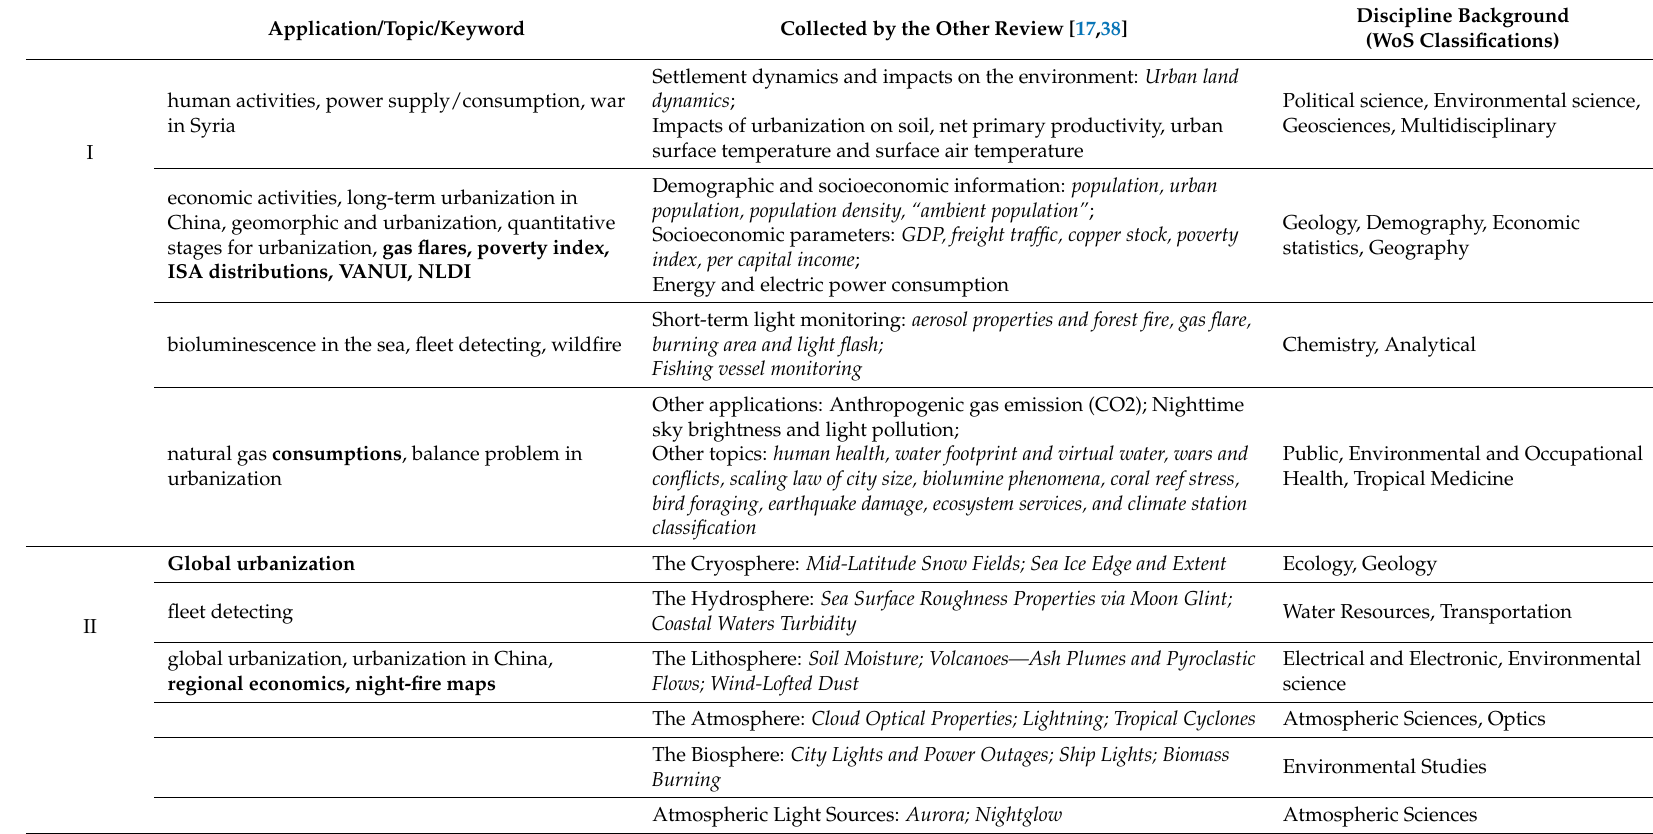
Table 8. The application/topic/keyword distributions and science background of DMSP/OLS (I) and VIIRS/DNB